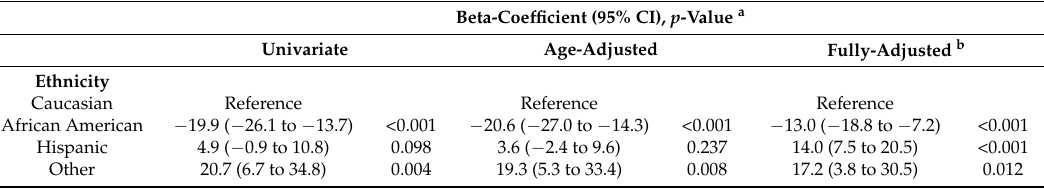
Table 2. Linear regression models of the association between ethnicity and energy intake adjusted magnesium intake a